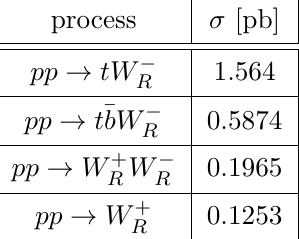
Table 1 . LO production cross sections of W R , computed for M R = 300 GeV, M 1 = 100 GeV and λ = 0 . 042